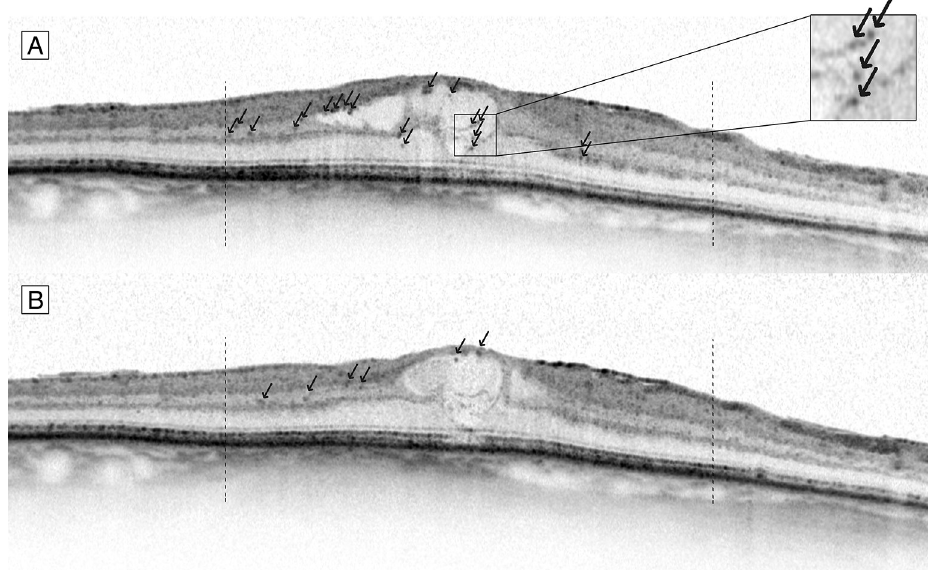
Fig 1. Hyperreflective foci on SD-OCT before and after treatment with anti-VEGF. Foveal centered spectral domain optical coherence tomography (SD-OCT) B-scan image of a patient with DME before (A) and after (B) 3 injections with anti-VEGF. Black arrows indicate hyperreflective foci, within 3000 μ m of the fovea (dashed